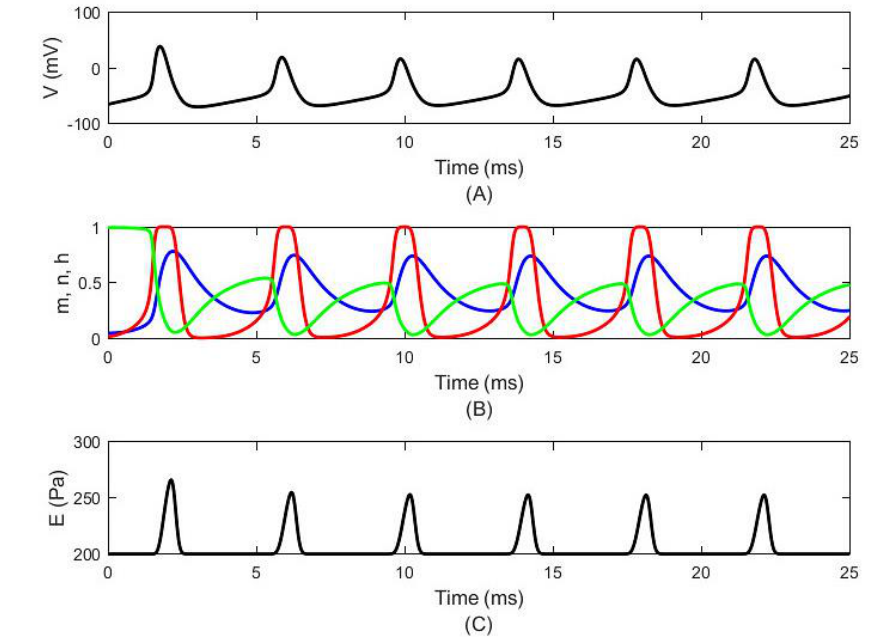
Figure 6. Results for both models of brain-on-a-chip and for both cases of NO synthesis (non-decaying and dynamic): (A) voltage 𝑽 , (B) displacements 𝒏 (blue line), 𝒎 (red line), and 𝒉 (green line), (C) Young’s modulus 𝑬